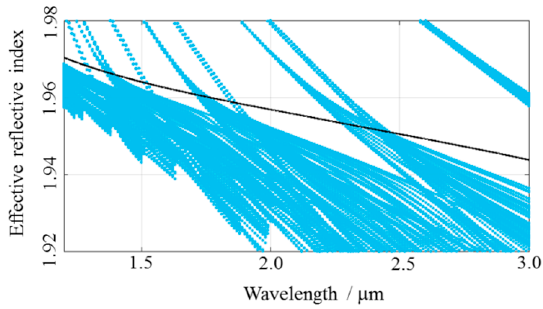
Figure 4. PBG map of the all-solid double-clad tellurite PBGF at d / Λ = 0.6.